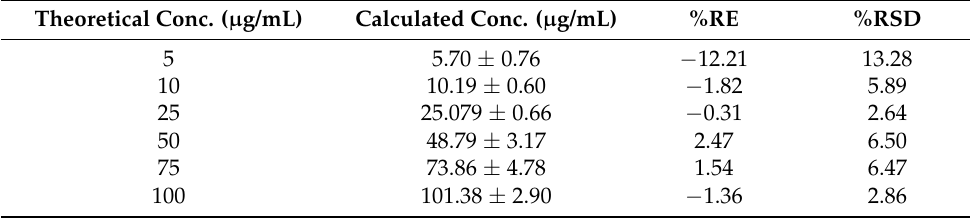
Table 6. Accuracy and precision inter-day data for APR standard solutions. High range. Theoretical Conc. ( µ